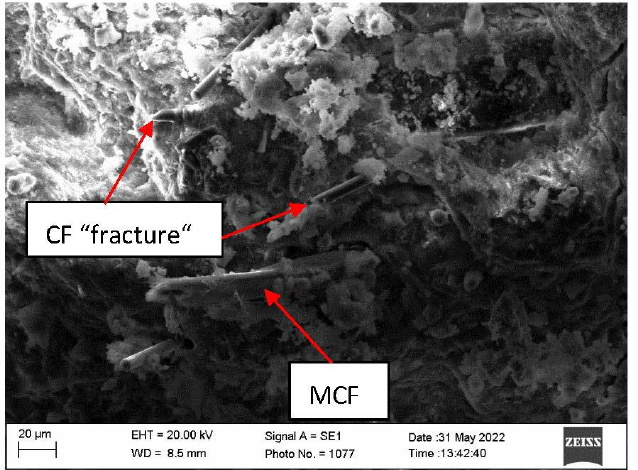
Figure 14. The CF “fracture” from cement matrix due to mechanical effect in AP100 samples before fire temperature effect.